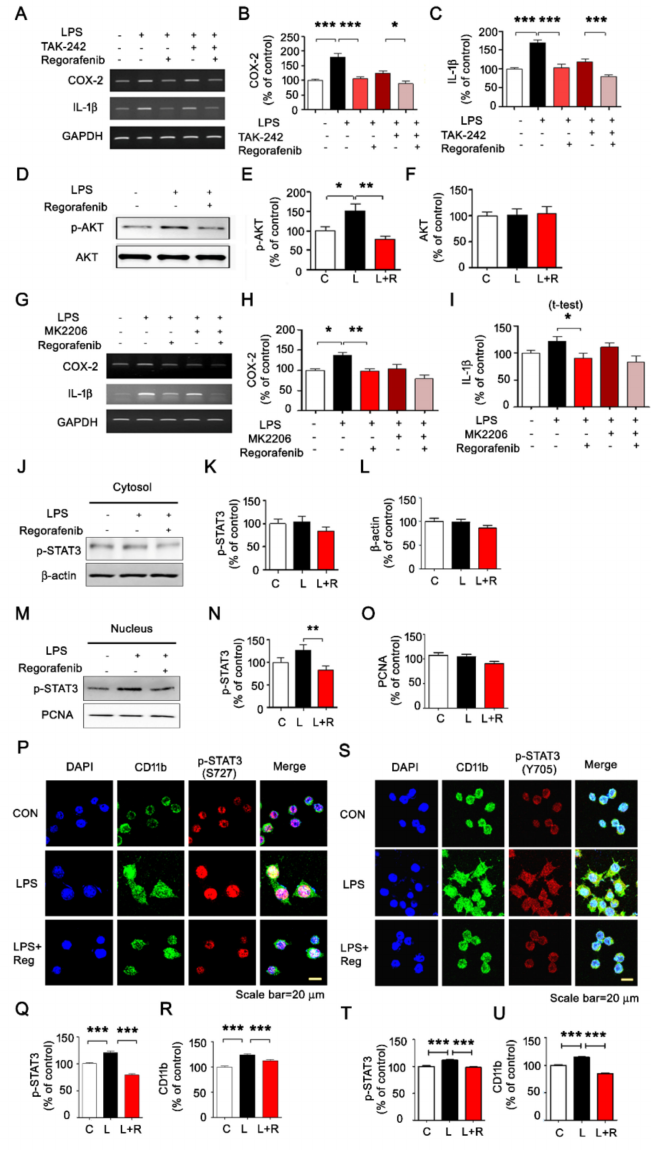
Figure 2. The e ff ects of regorafenib on LPS-induced proinflammatory cytokine levels are dependent on TLR4 / AKT signaling. ( A ) BV2 microglial cells were pretreated with LPS (1 µ g / mL) or PBS for 30